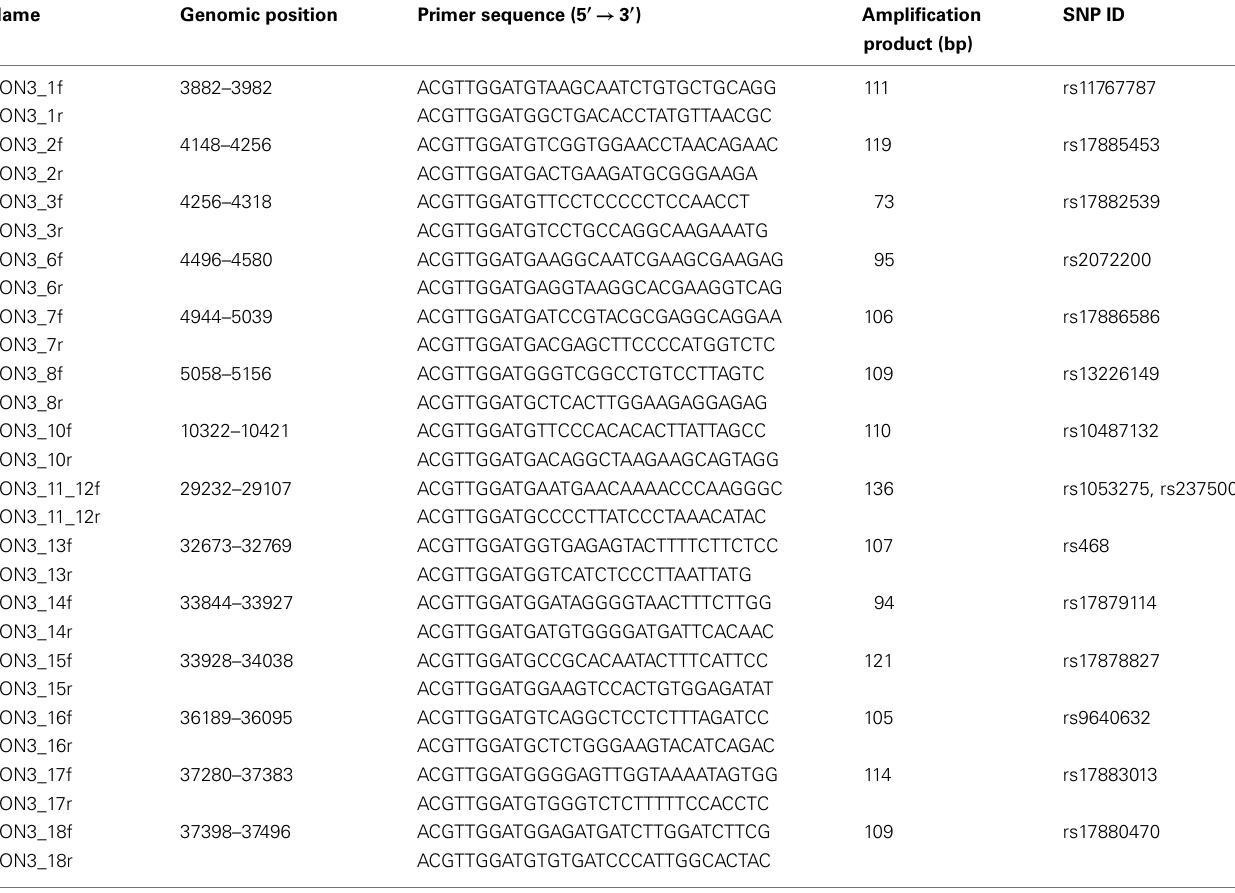
TableA4 | Amplification primers used in MALDI-TOF MS